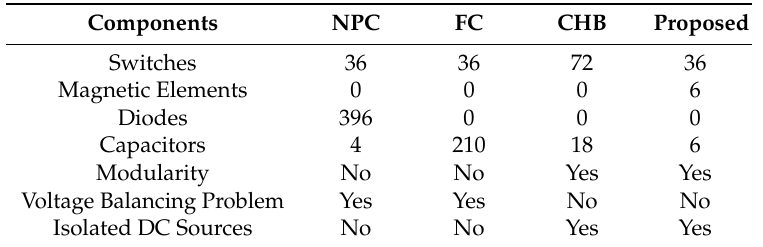
Figure 14. Currents inside the proposed converter. Table 2. Component comparison of the proposed converter and traditional multilevel